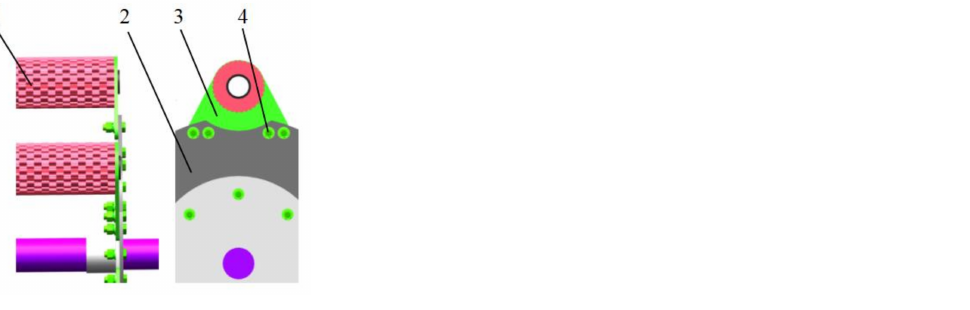
Figure 4. Installation diagram of “staggered teeth” threshing element: 1. “Staggered” rubber roller; 2. spoke; 3. arc fixed plate; 4. bolt group.